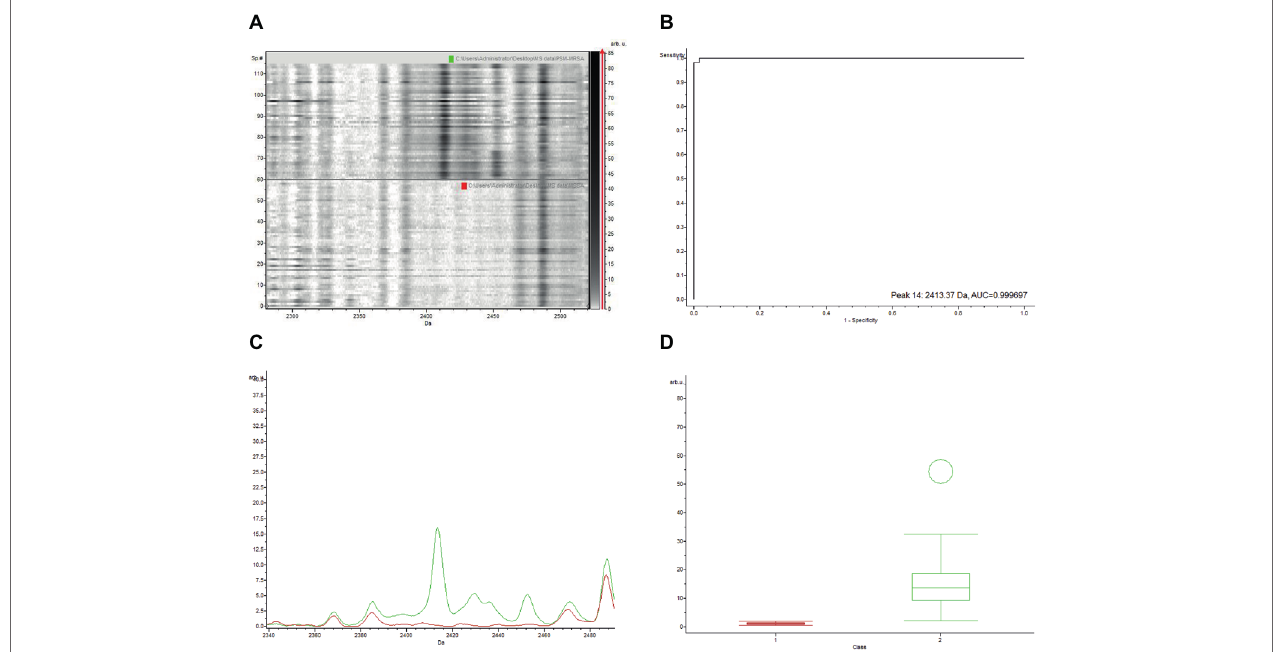
FIGURE 1 | Discrepancy of the characteristic 2,413 m/z peak between PSM-MRSA and MSSA classification models. (A) The gel view of the respective section. The red arrow indicates the characteristic peak of 2,413 m/z. Intensities of peaks were expressed in arbitrary units (arb.u.). (B) The AUC of the 2,413 m/z peak. (C) Average spectra of 2,413 m/z peak. Green line and red line represent for PSM-MRSA and MSSA group, respectively. (D) Display of single peak variance of 2,413